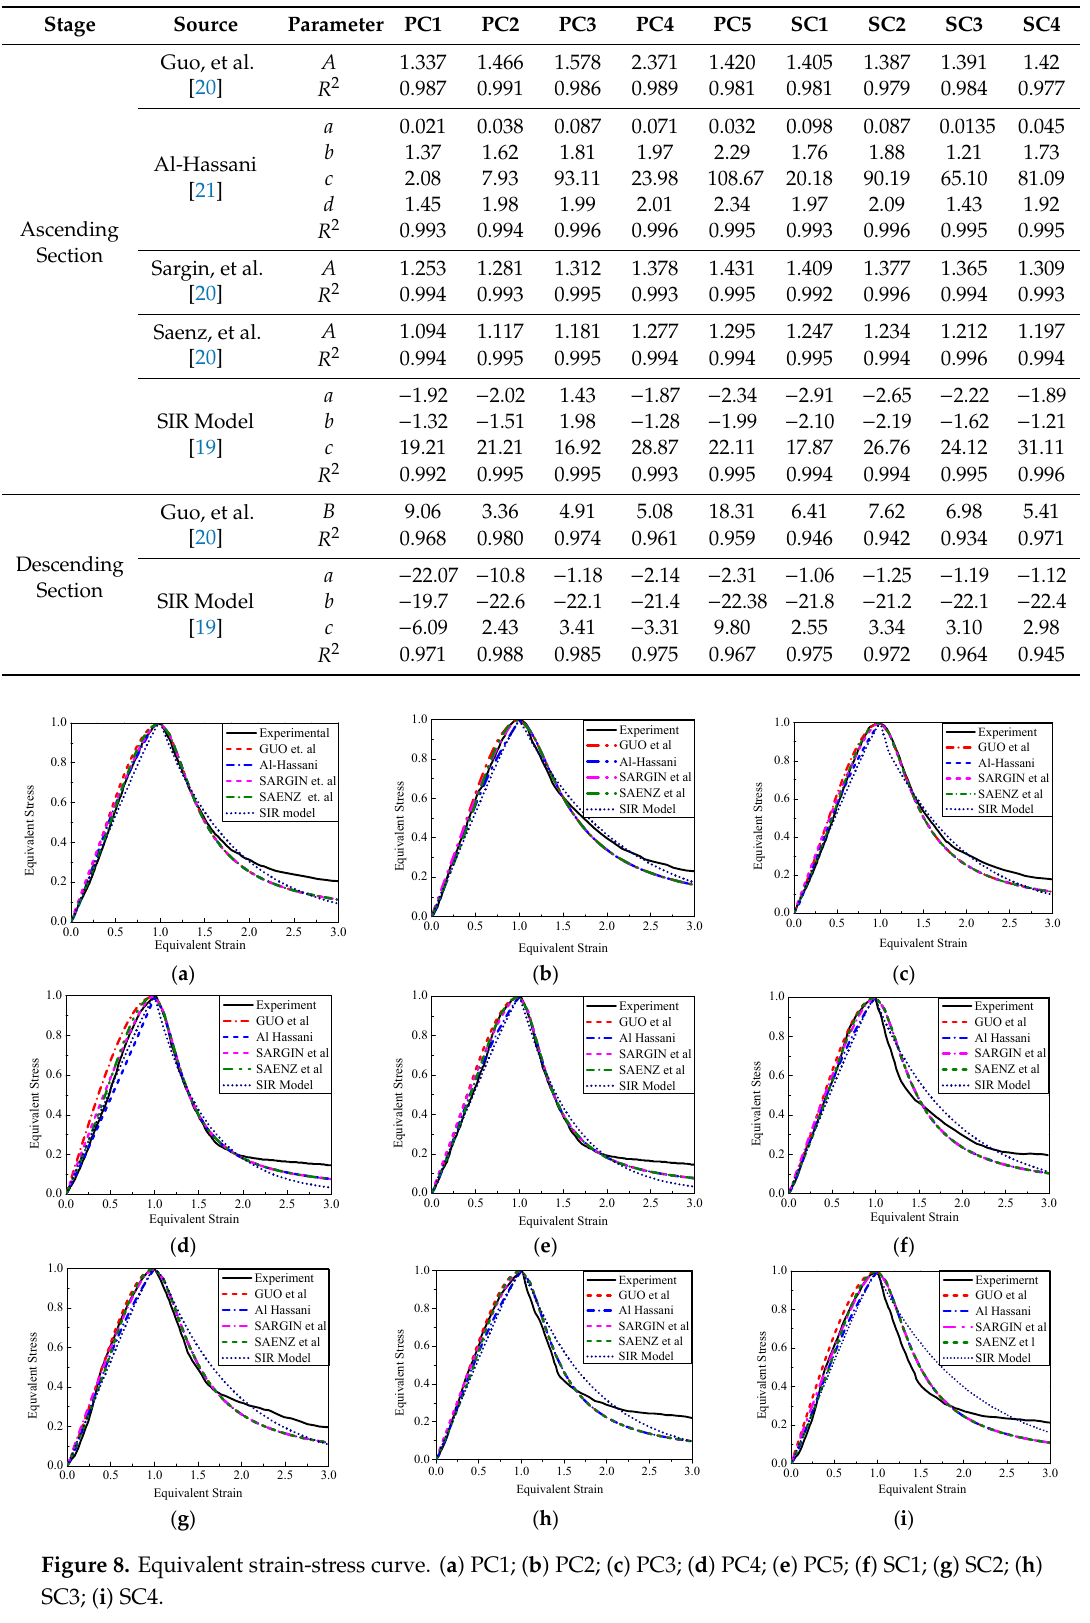
Table 5. Fitting parameters and determining coe ffi cient test.